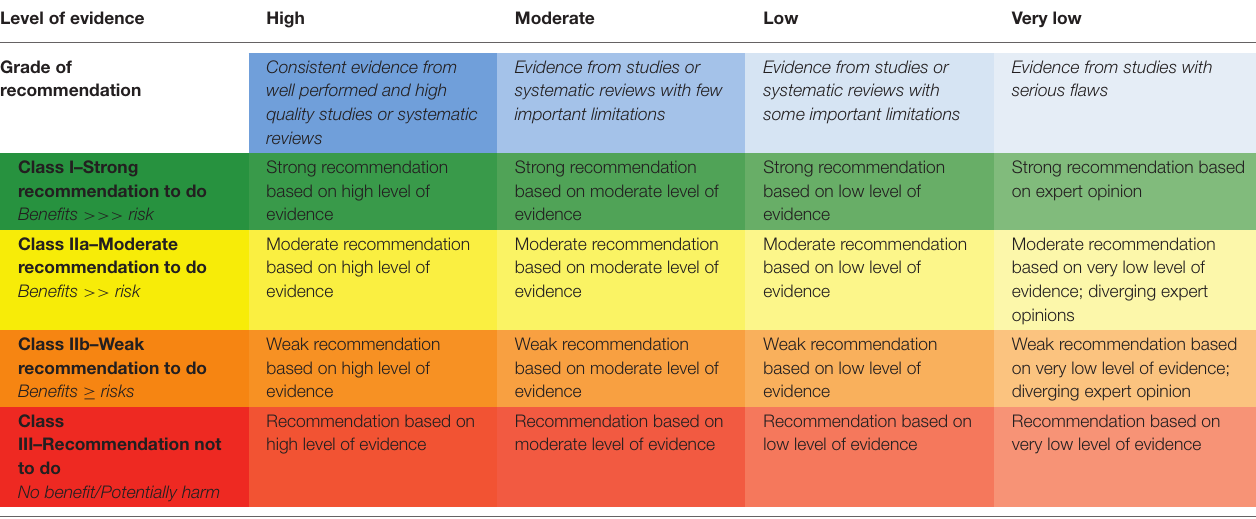
TABLE 5 | Four-levels color schema in order to integrate the quality of evidence assessment and the strength of